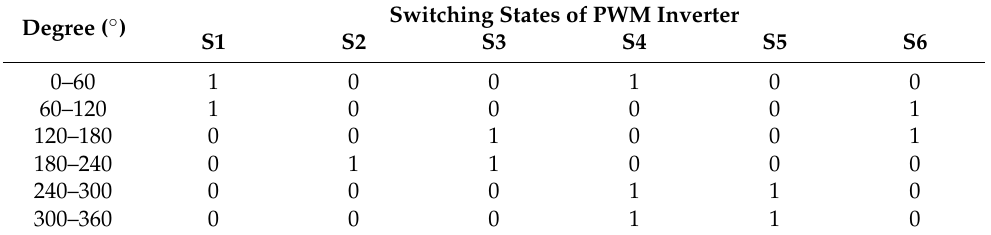
Table 1. Input and Output Specifications.